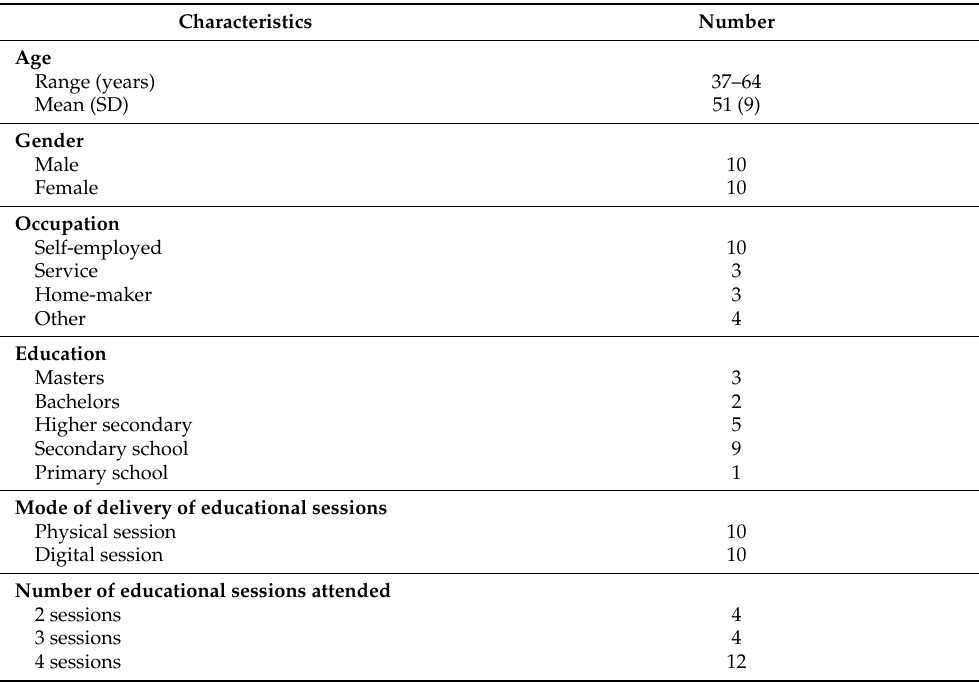
Table 1. Sociodemographic characteristics of participants (n = 20).